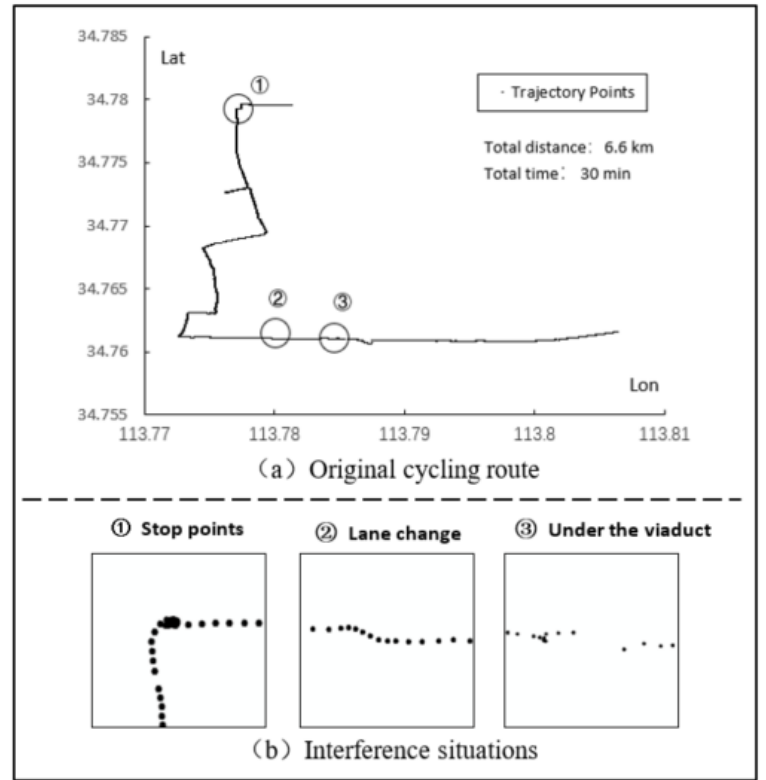
Figure 12. The fourth example of cycling trajectory.